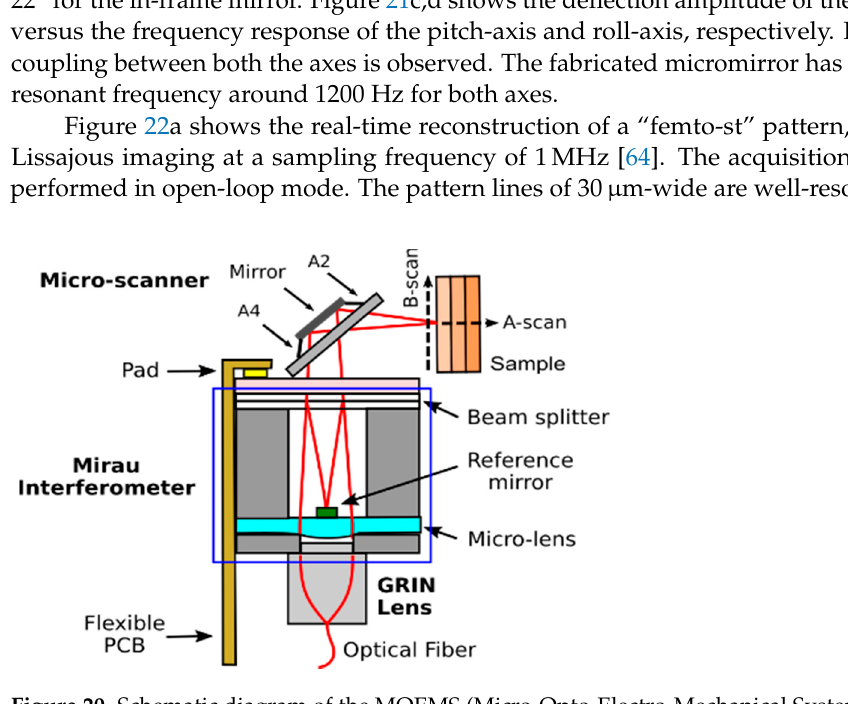
Figure 21. Electrothermal mirror: ( a ) schematic and ( b ) microphotograph of a MEMS scanner assembled on top of a Mirau interferometer. The frequency response for inner pitch axis ( c ) and roll-axis ( d ). The inner mirror plate is connected to a rigid frame via a pair of torsional bars in two diametrically opposite ends located on the rotation axis. A pair of electrothermal bi- morphs generates a force onto the perpendicular free ends of the mirror plate in the same angular direction. An array of electrothermal bimorph cantilevers deflects the rigid frame and a mechanical stopper maintains the position of the mirror inclined at 45° from the optical axis. The performed scans reach large mechanical angles of 32° for the frame mirror and 22° for the in-frame mirror. Figure 21c,d shows the deflection amplitude of the micro- mirror versus the frequency response of the pitch-axis and roll-axis, respectively. Here, a small coupling between both the axes is observed. The fabricated micromirror has a me- chanical resonant frequency around 1200 Hz for both axes. Figure 22a shows the real-time reconstruction of a “femto-st” pattern, obtained by Lissajous imaging at a sampling frequency of 1 MHz [64]. The acquisition of data was performed in open-loop mode. The pattern lines of 30 µm-wide are well-resolved.